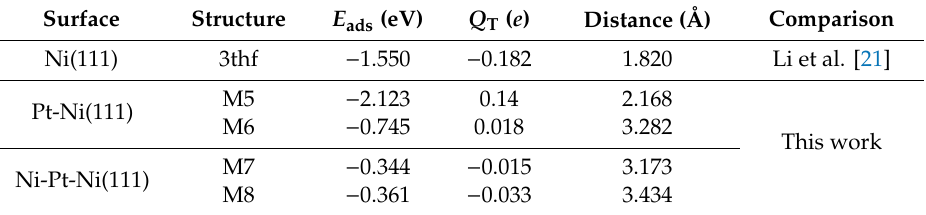
Table 2. The adsorption parameters of SOF 2 adsorbed by Ni(111), Pt-Ni(111), and Ni-Pt-Ni(111) surfaces.